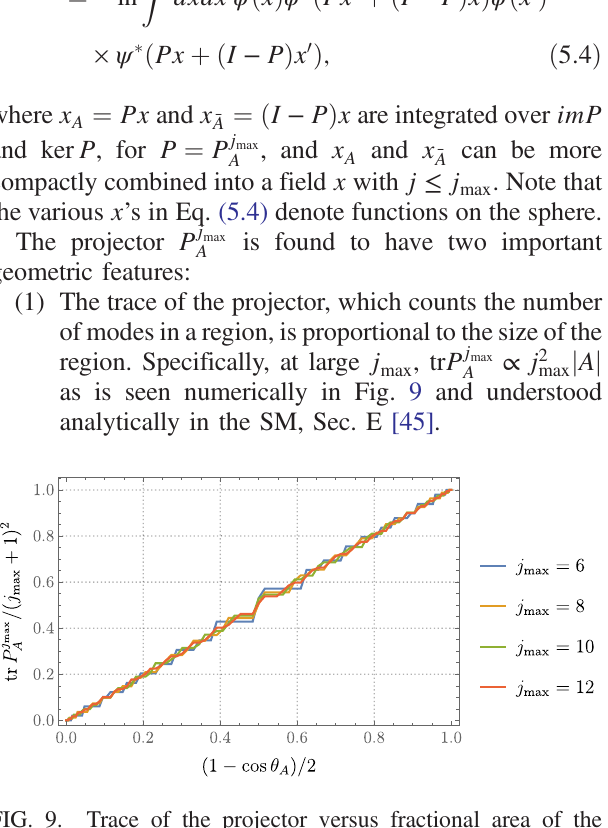
FIG. 9. Trace of the projector versus fractional area of the region (a spherical cap with polar angle θ ), with different A angular-momentum cutoffs j . A linear proportionality is max observed at large j . The discreteness in the plot arises because max the finite j space of functions cannot resolve all max